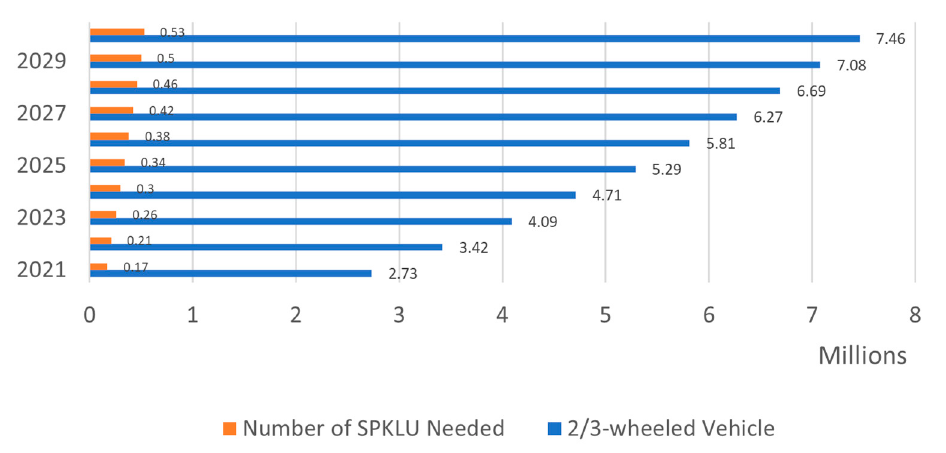
Figure 8. KESDM projection on the number of EVs in Indonesia from 2021 to 2030.